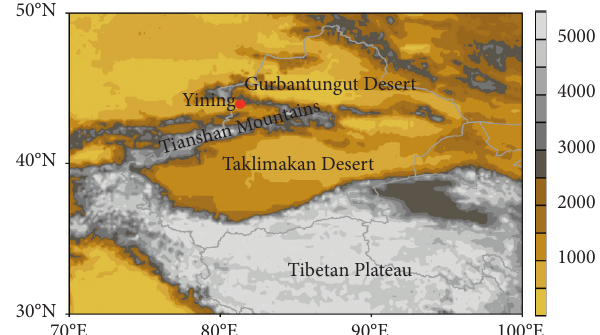
Figure 1: Location of the observation site (red filled circle) and the topography